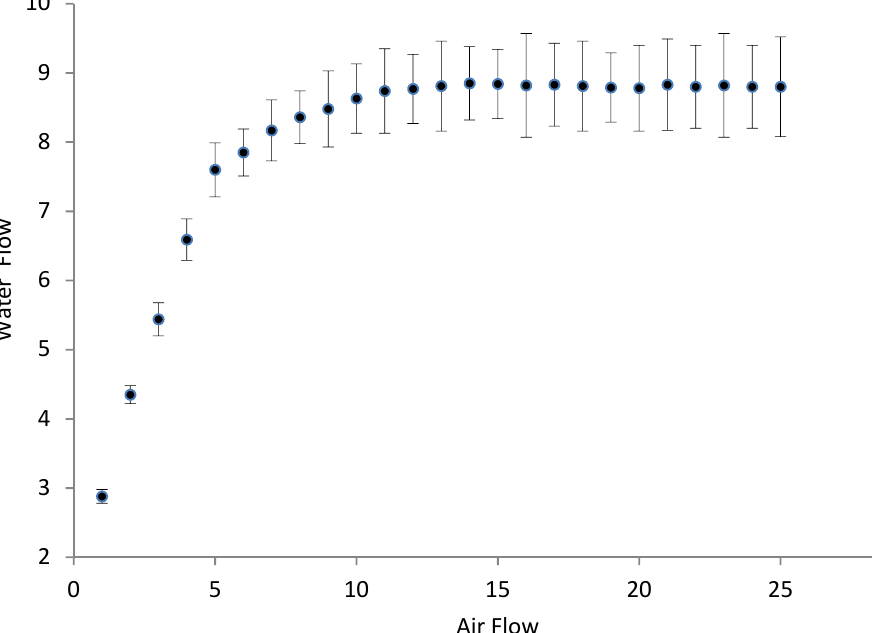
Figure 5. Water flow (L min − 1 ) in the ordinate vs. air flow (L min − 1 ) in the abscissa.